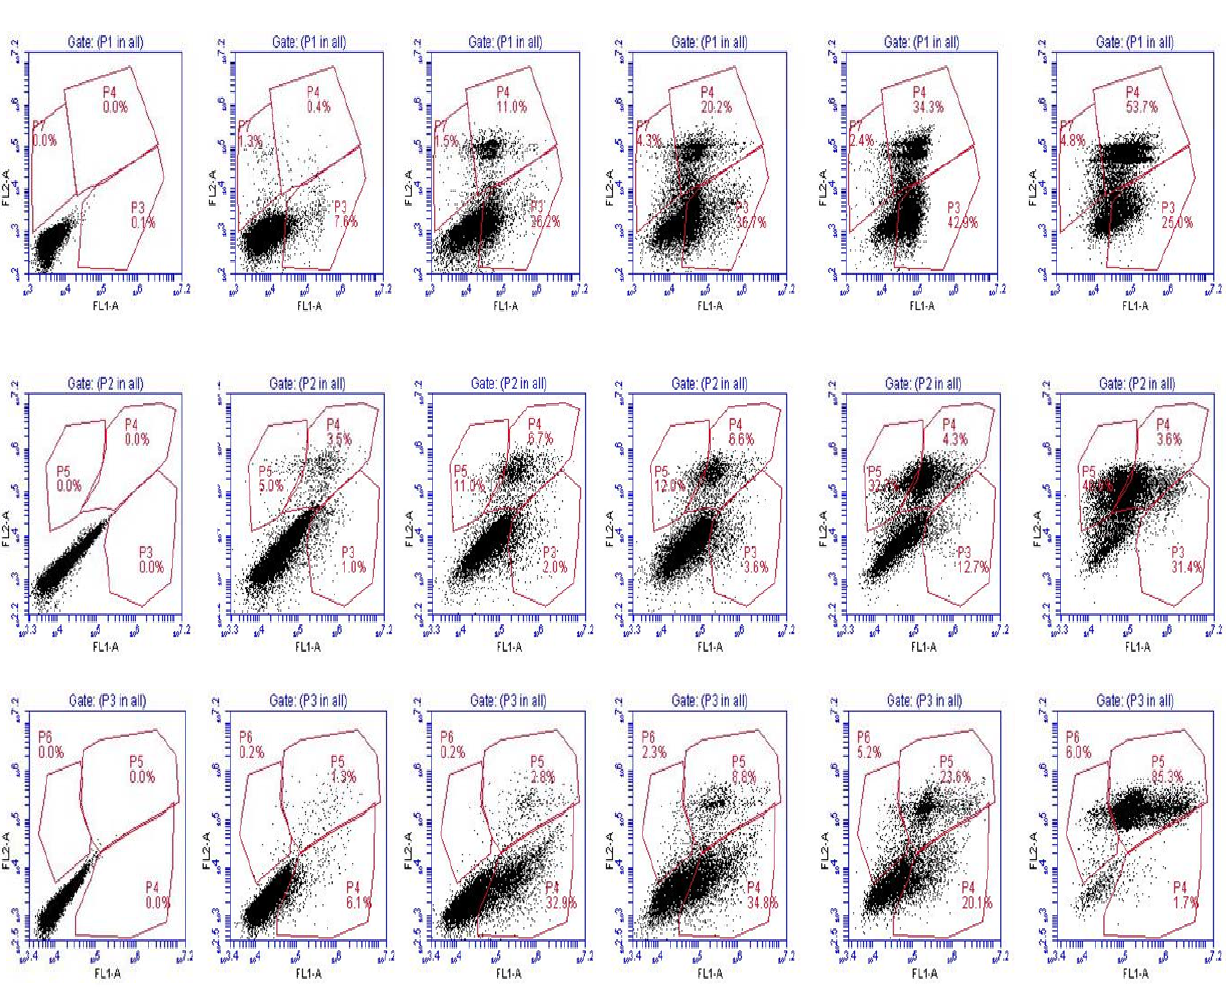
Figure S1. FACS analysis of pancreatic cancer cells stained with annexin V-FITC and